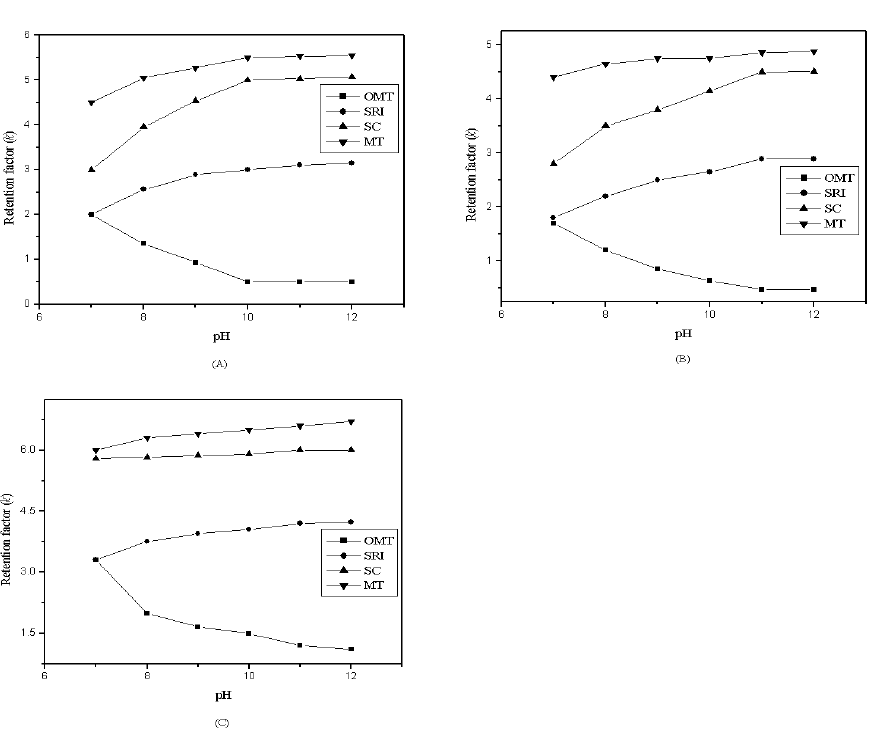
Figure 3. Effect of k of four compounds by using different concentrations of [BMIM][BF